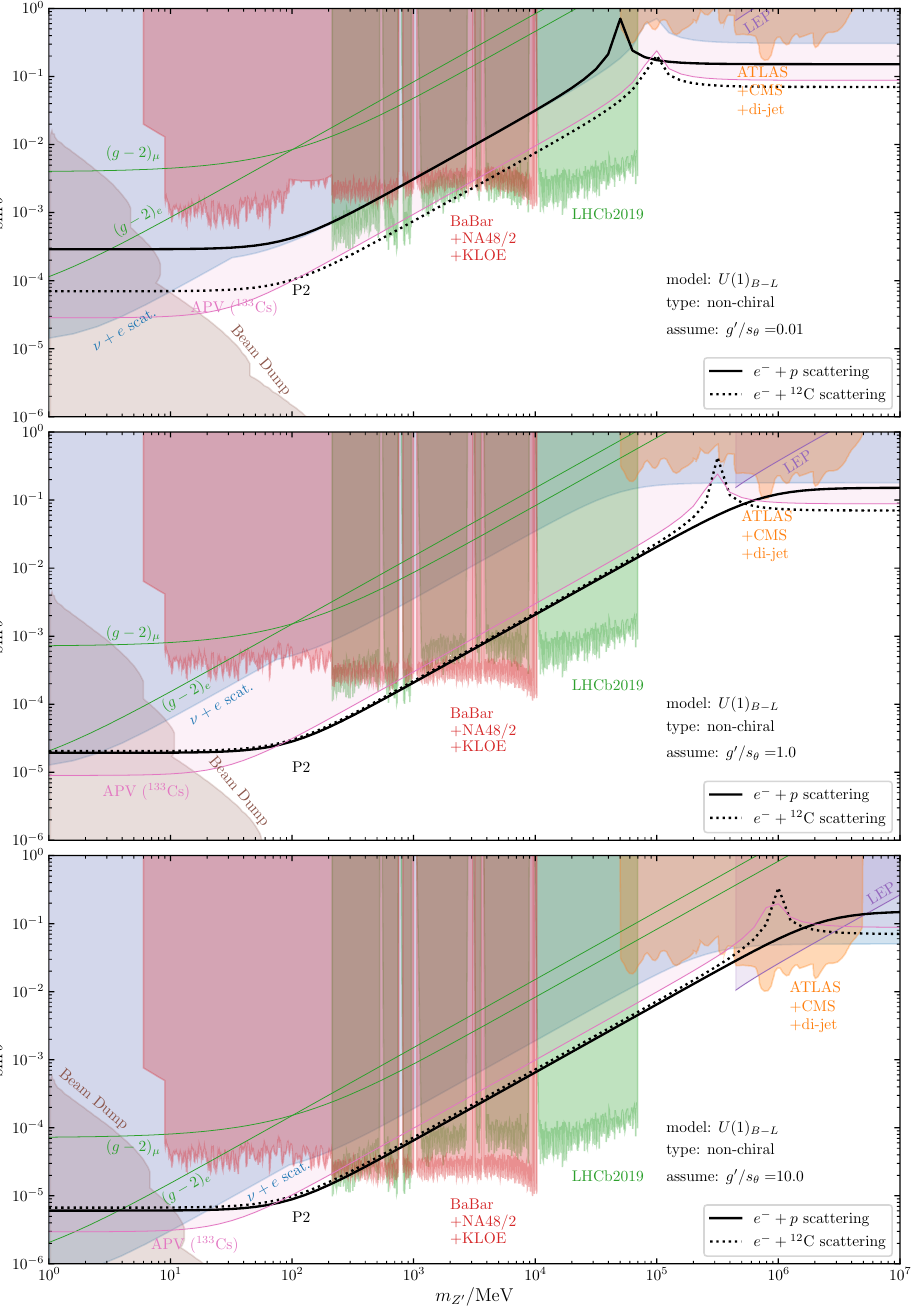
Figure 6 . Similar to figure 5 but for the U(1) B − L